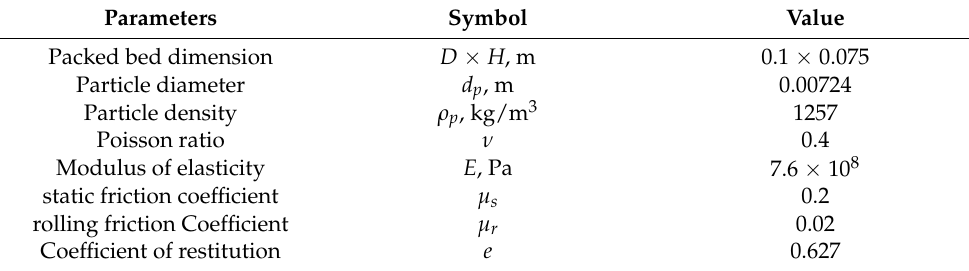
Table 1. Soybean particle parameters used in the DEM simulation.